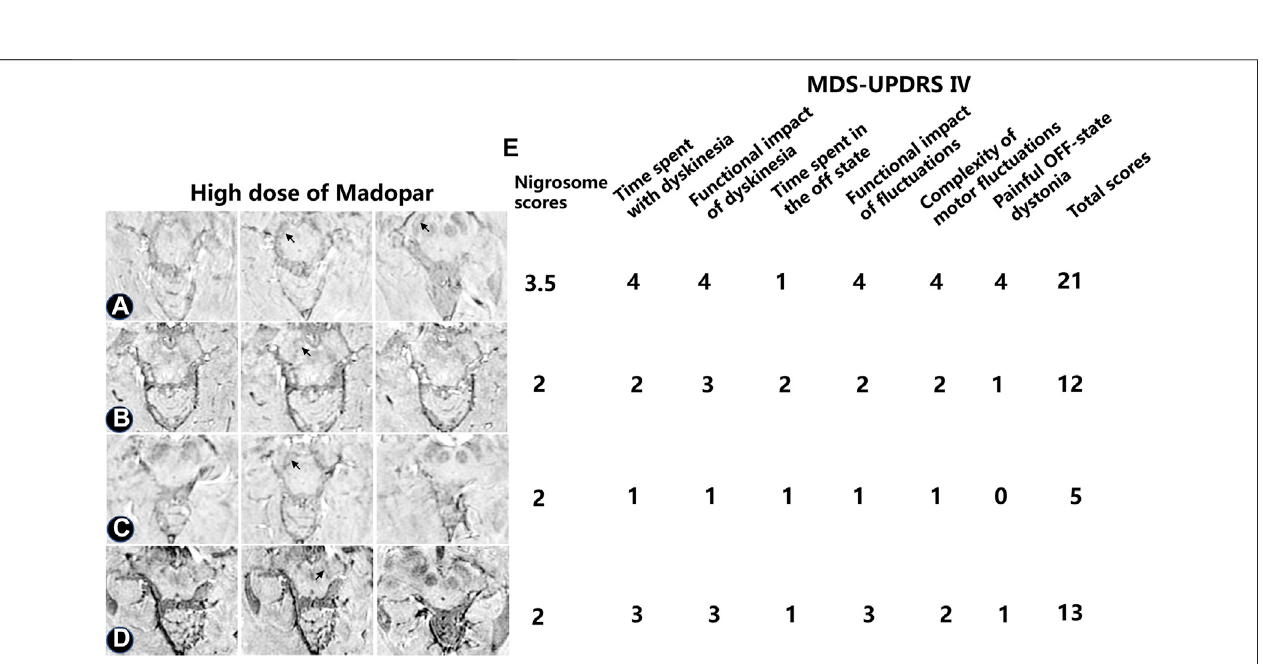
FIGURE 6 | Alterations in iron aggregation in the substantia nigra in four PD patients treated with high-dose levodopa with peak-dose dyskinesia or biphasic dyskinesia. The nigrosome was visible as a bright area (A – D) The nigrosome was visible (black arrow) as a bright area. (E) The dyskinesia was evaluated by utilizing the UPDRS Ⅳ